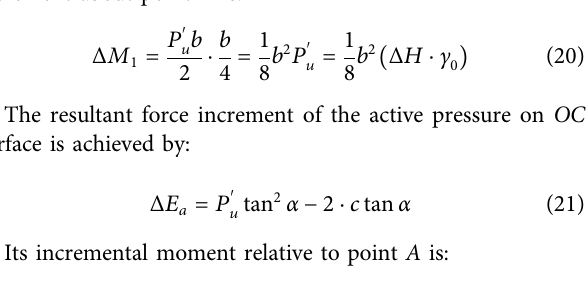
Frontiers in Earth Science |